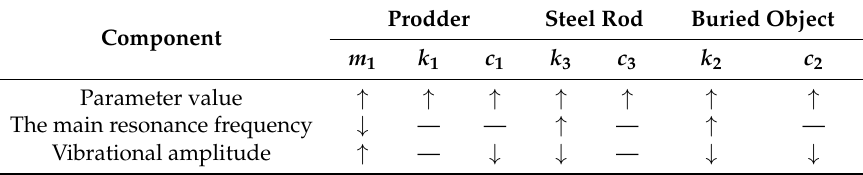
Table 2. Effects of Parameters of the System on Its Vibrational